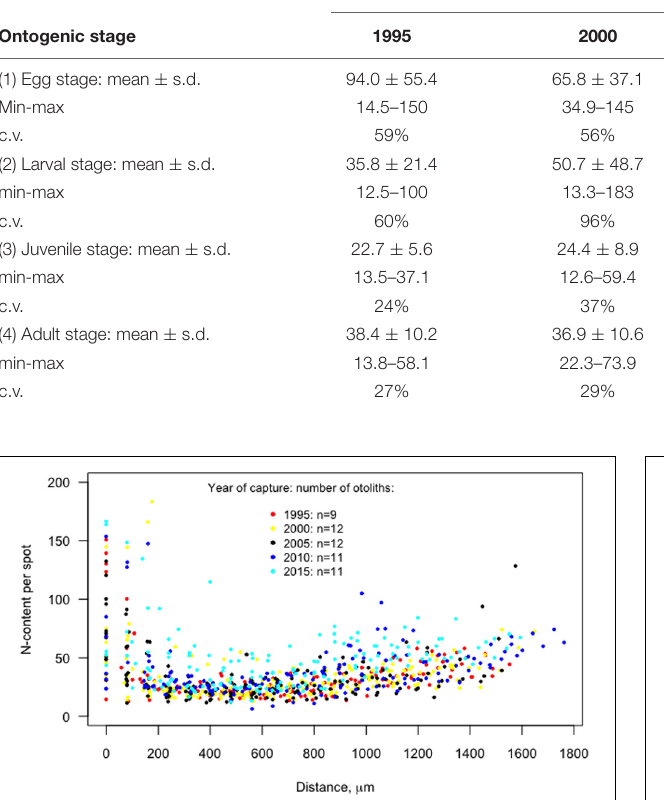
Year of capture